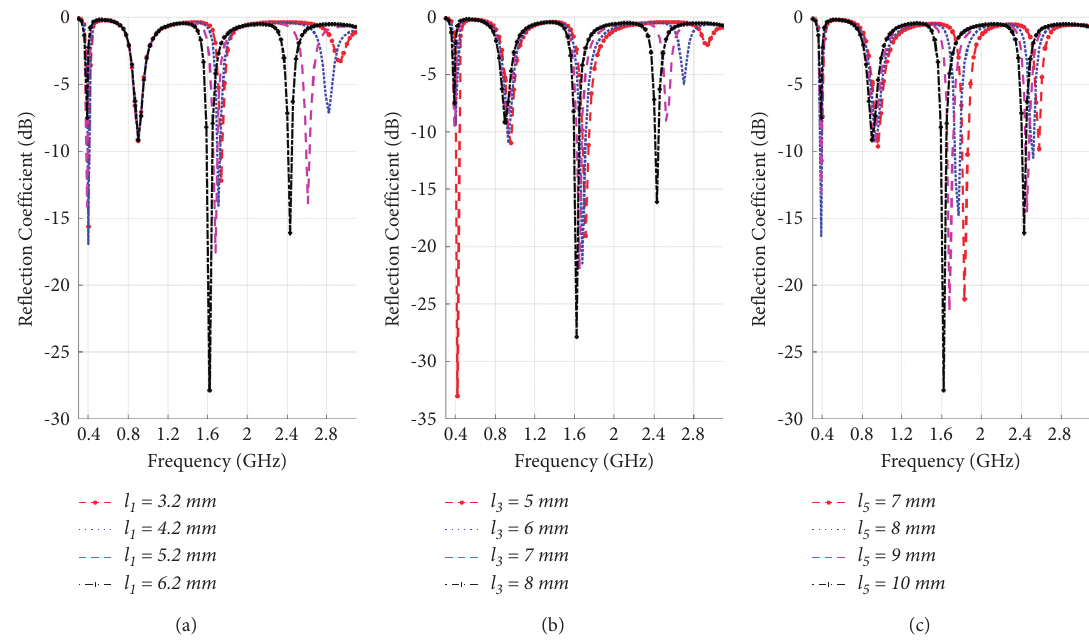
Figure 5: Effect of shortening the cutting slots of (a) l